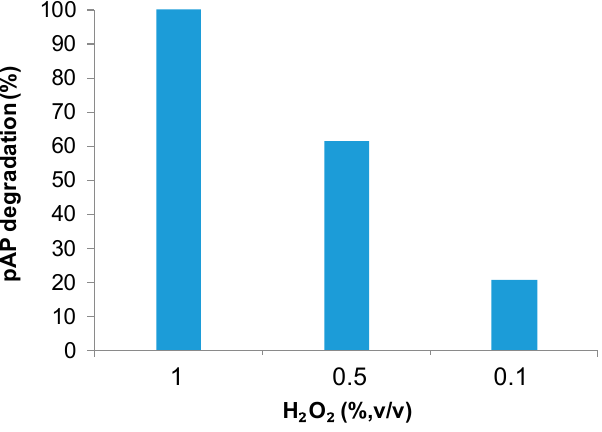
Figure 8. Effect of the amount of hydrogen peroxide in the pAP degradation catalyzed by hydrogen peroxide. Reaction conditions were 3 mg catalyst, 10 mL of pAP solution in distilled water (100 mg/L), room temperature for 15 min.